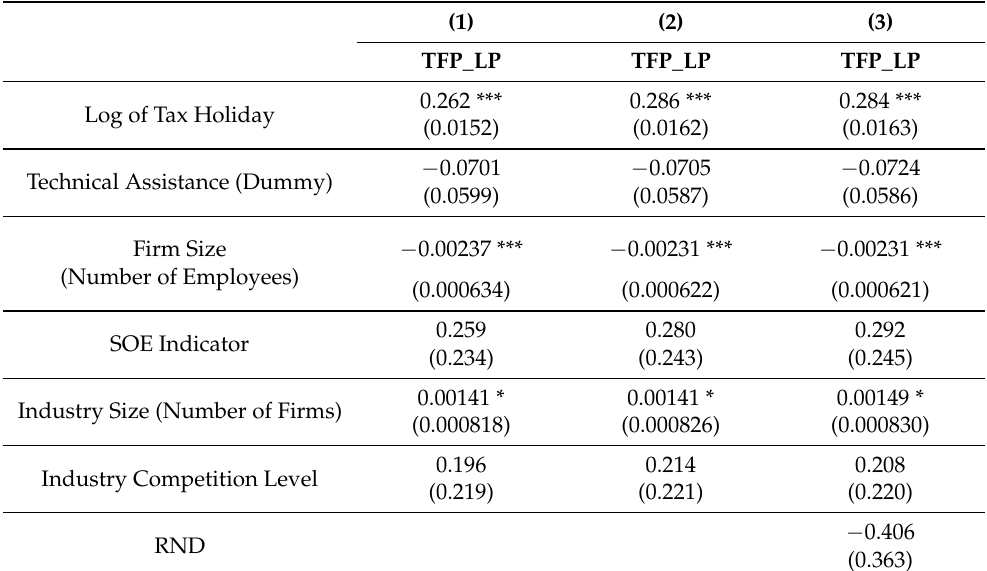
Table A4. Robustness Checks with TFP Measured Using Levinsohn–Petrin method